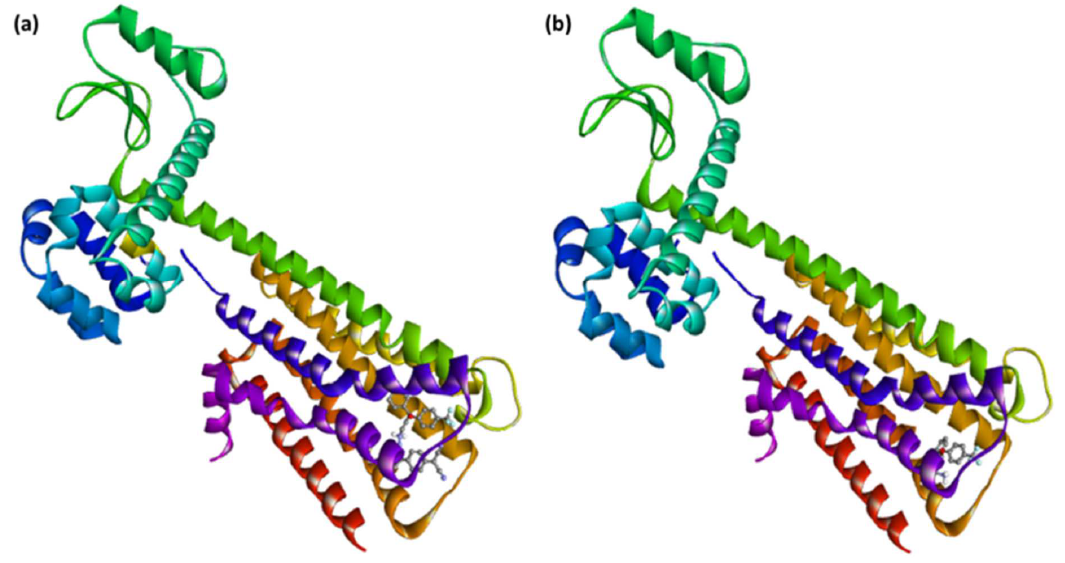
Figure 7. Best docking pose showing a helical model of dopamine docked with ( a ) [(SRX)(TCNQ)] and ( b )